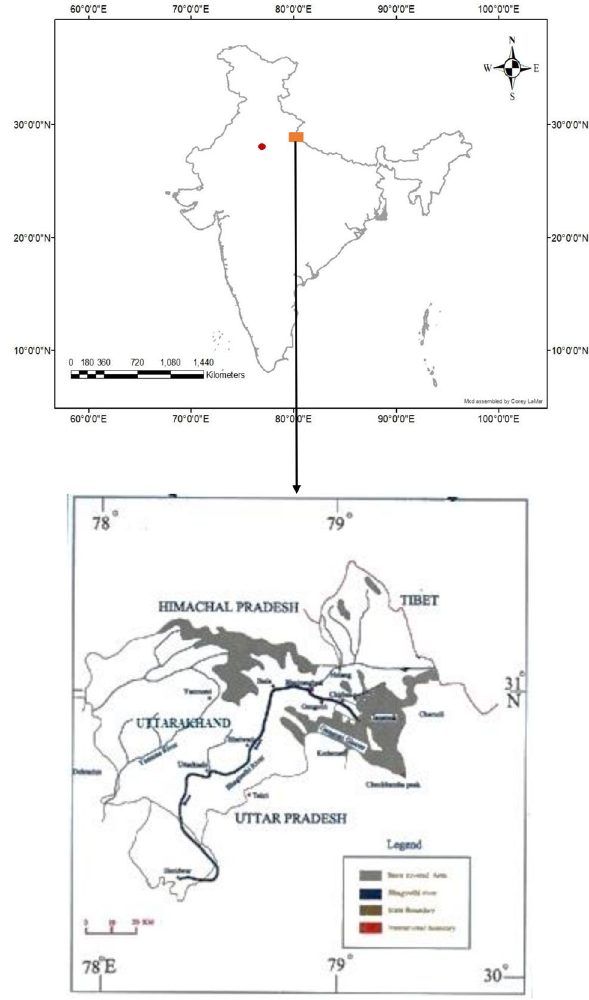
Fig. 1 Location map of the Gangotri glacier, Garhwal